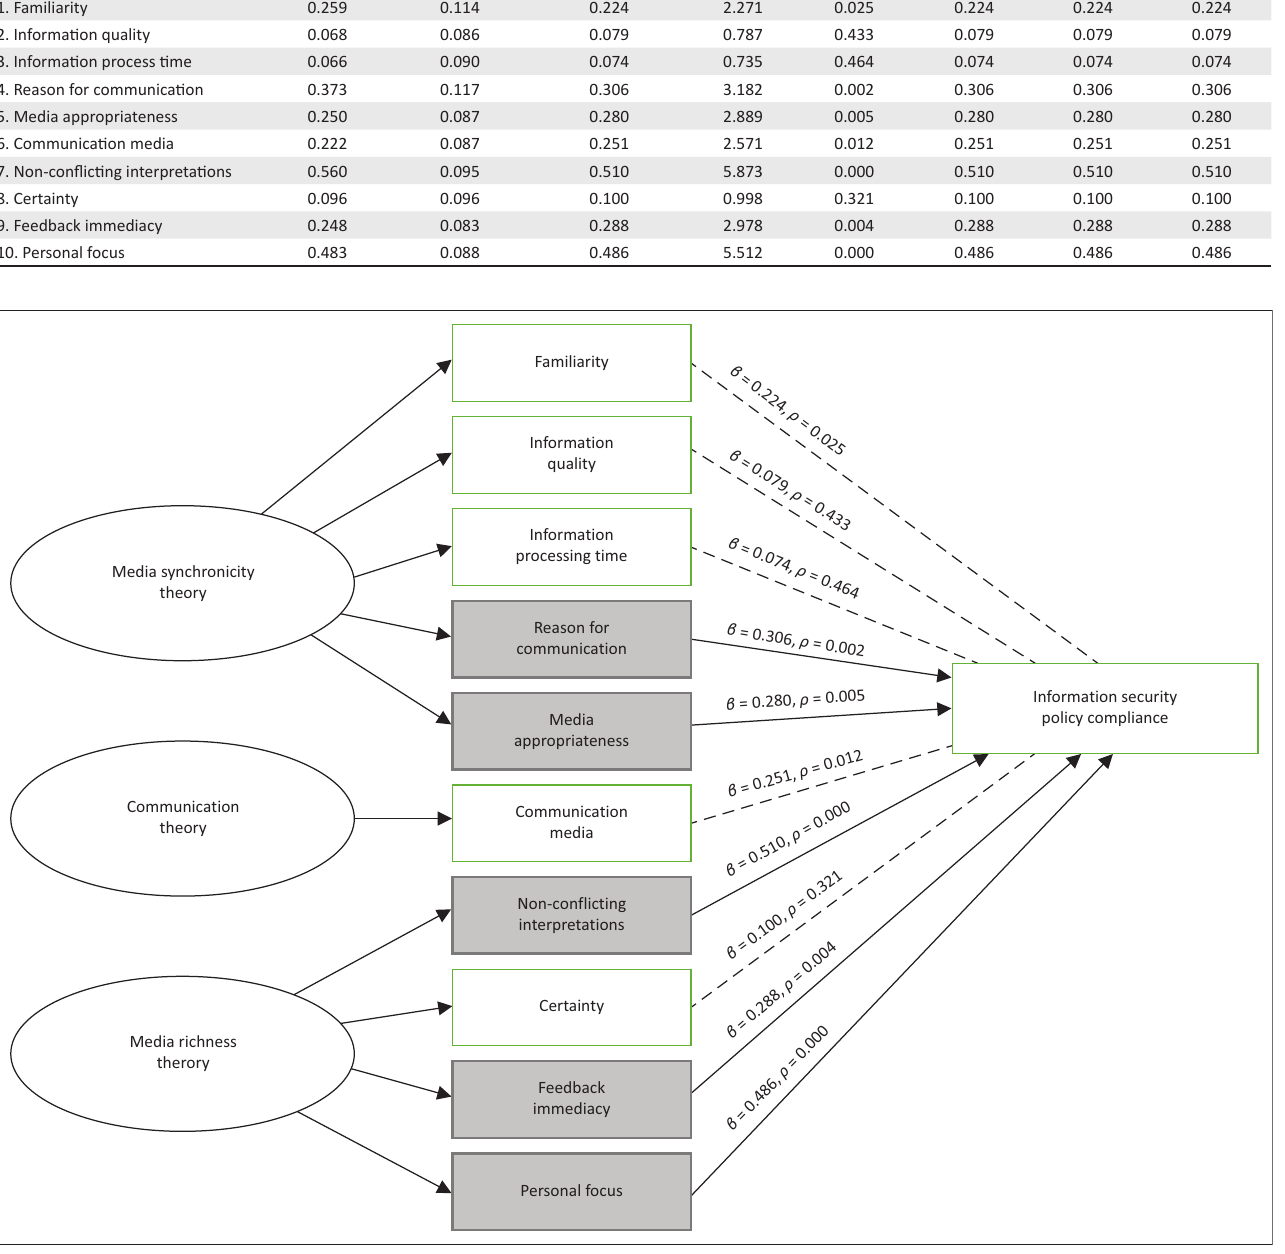
FIGURE 5: Miscellany of perception and determinism predicting compliance.